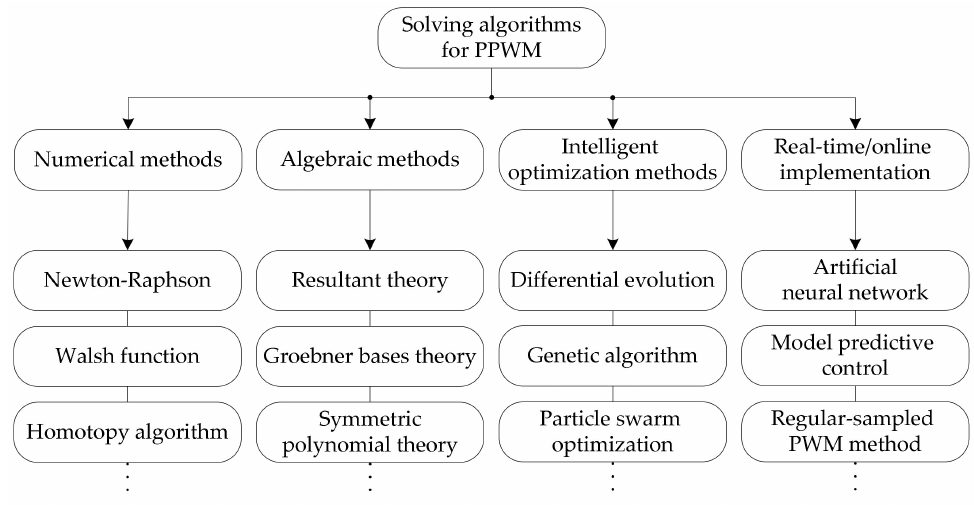
Figure 6. Classification of PPWM solving algorithms and